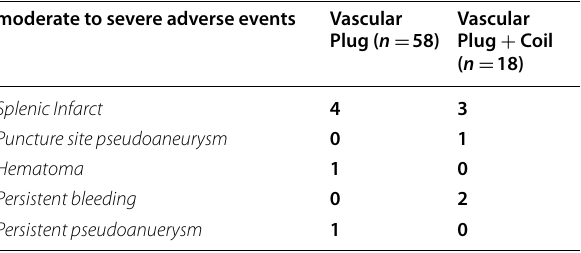
Table 4 Complications between vascular plug and vascular plug with coil